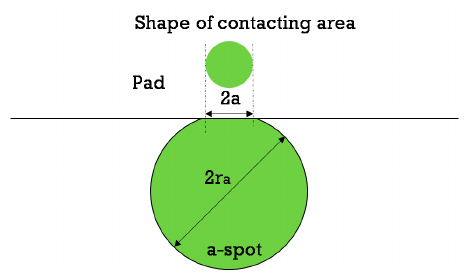
Figure 17. Schematic representation of contact state of an a-spot.